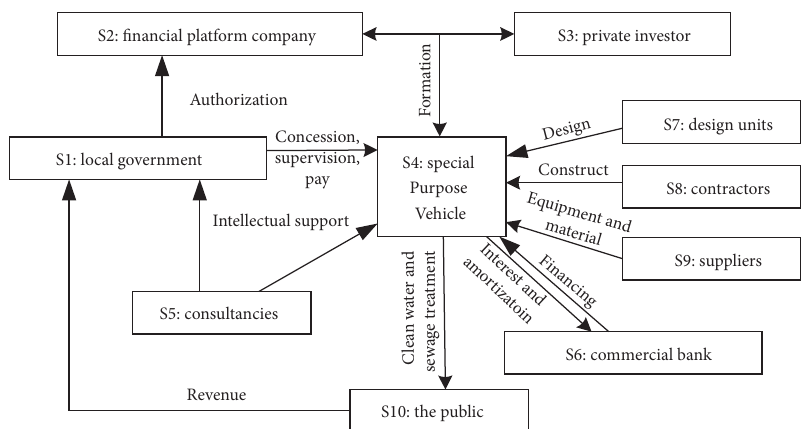
Figure 3: Structure of stakeholders in the water purification and sewage treatment PPP project. Table 1: Risk checklist for the PPP case